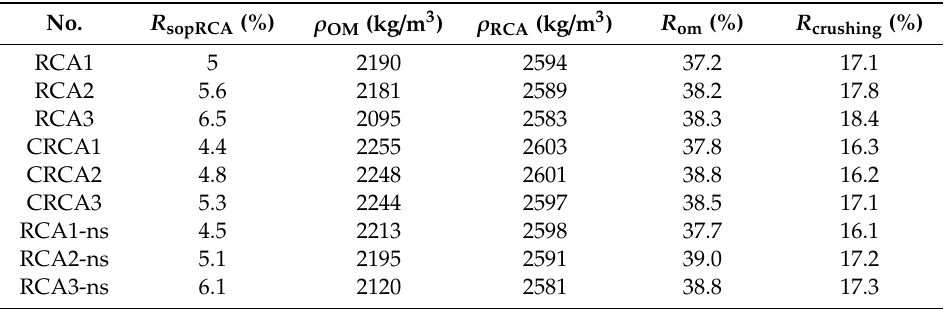
Table 2. Properties of